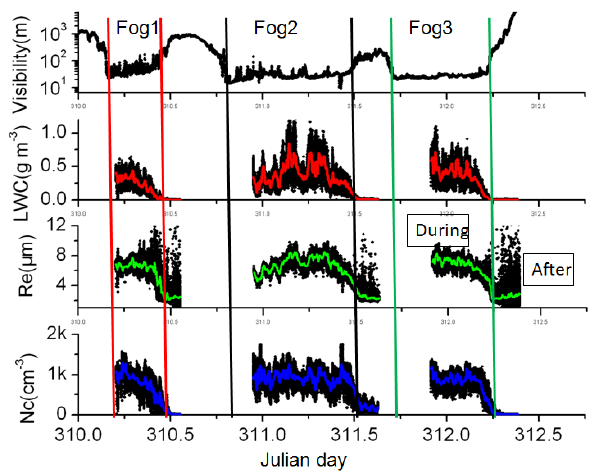
Fig. 5. The characteristics of fog droplets, including fog droplet number concentration (Nc), effective radius (Re), and liquid water content